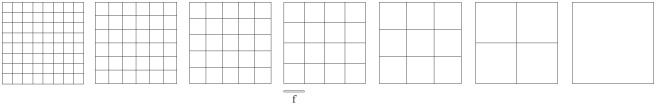
Sequence of box covering iteration for telescopic analysis.Example of grids applied on top of networks as a function of fuzziness. Leftmost grid has low fuzziness f = 0.125 whereas the rightmost has f = 1. The granularity of the spectrum in this example is equal to 7. In this paper, we only consider linear increase of f.